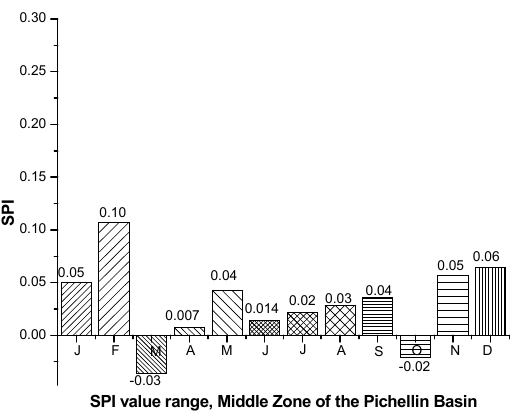
Figure 11. Standardized precipitation index (SPI), high zone.